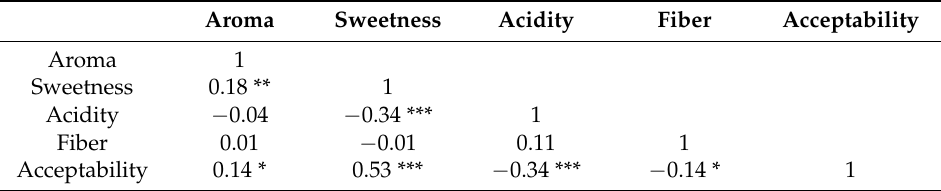
Table 4. Correlation between acceptability and sensorial characteristics.